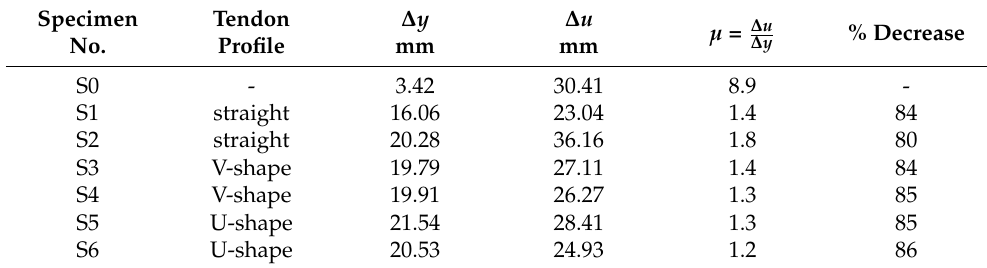
Table 5. Ductility analysis of all